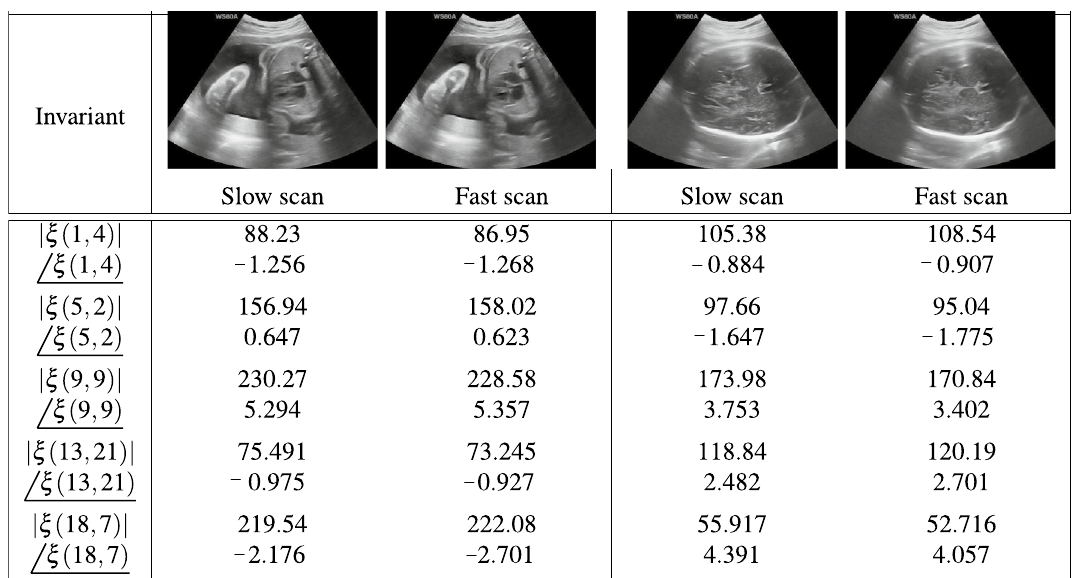
Table 2. The values of the frequency invariants including amplitude ( | ξ( u , v ) | ) and phase (